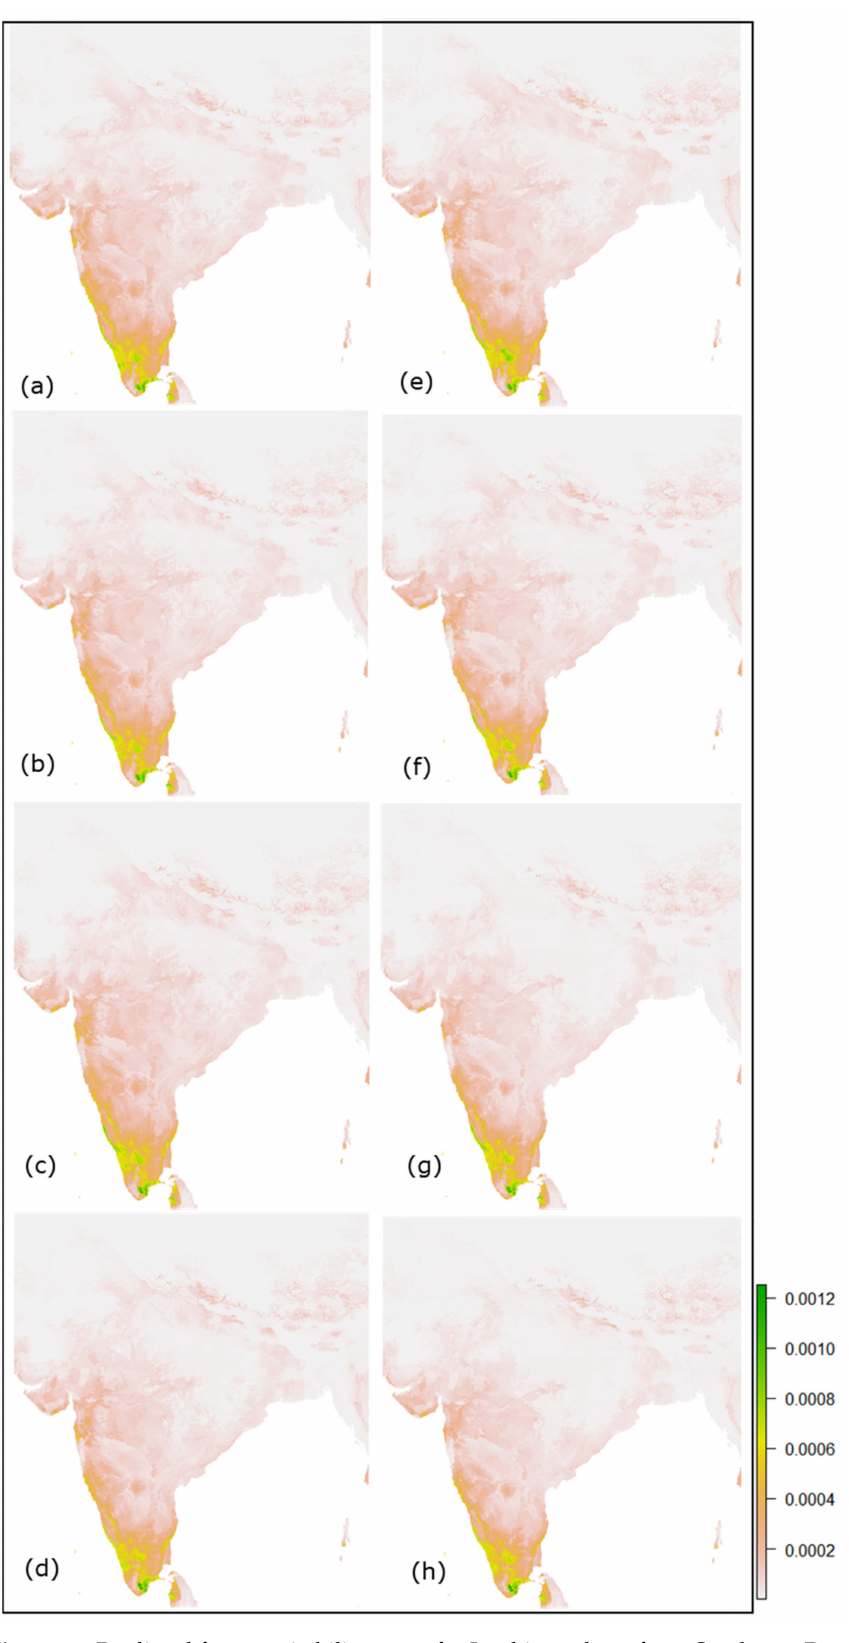
Figure 10. Predicted future suitability maps for Jacobin cuckoos from October to December: ( a – d ) and ( e – h ) represent the SSPs 2.6, 4.5, 7.0 and 8.5 for 2030 and 2050,